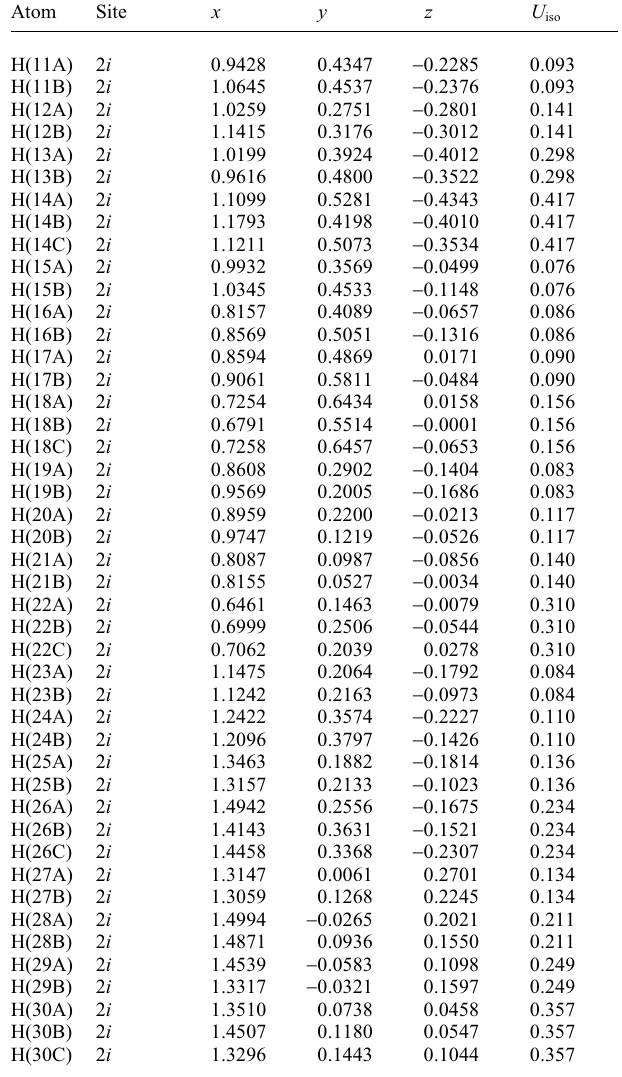
Table 2. Atomic coordinates and displacement parameters (in Å 2 )